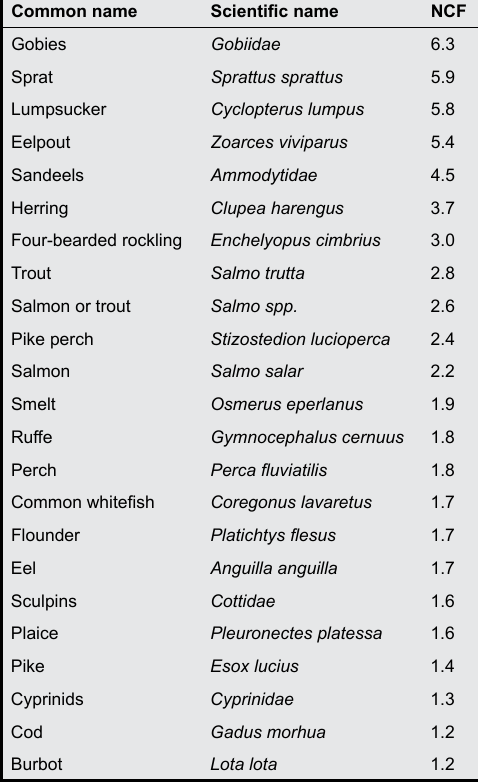
Table 3. Numerical correction factors (NCFs) calculated from otolith width for prey species in this study.